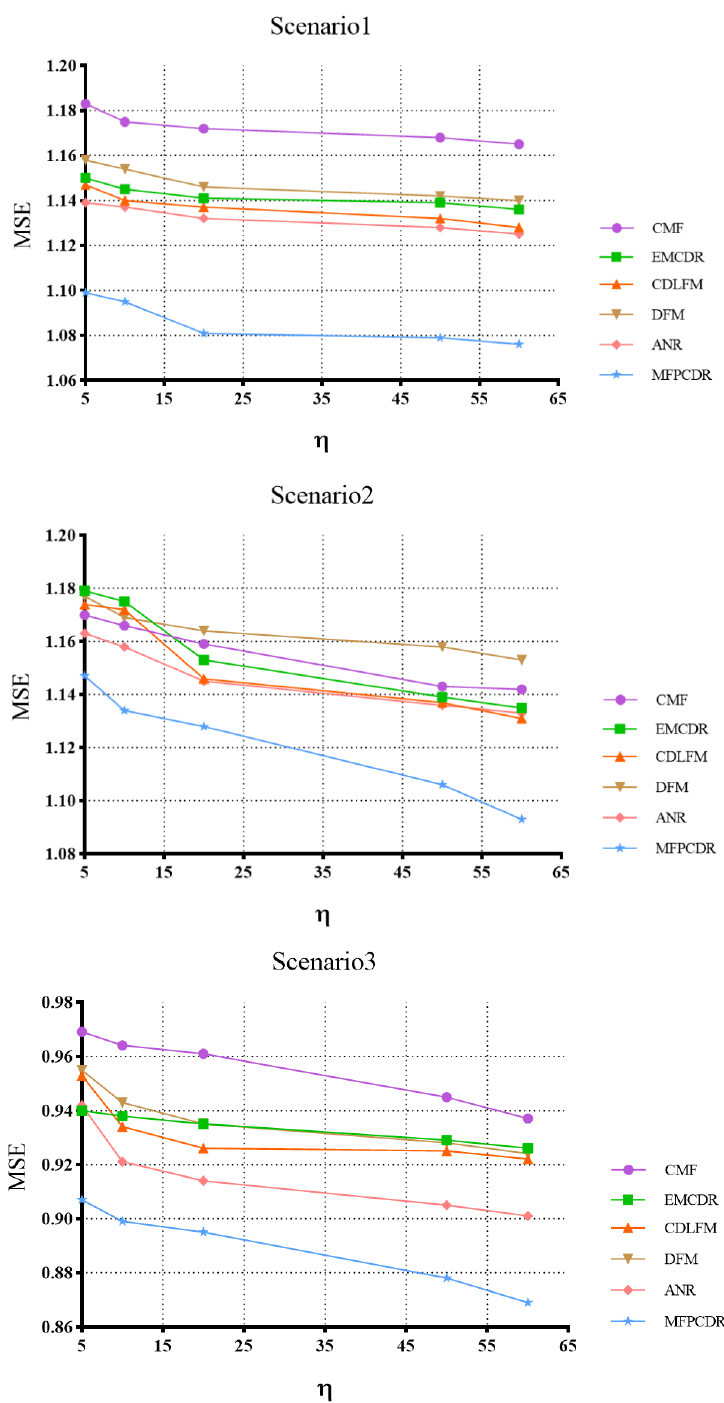
Figure 4. Impact of the proportion of overlapping users ( η represents the proportion of overlapping users). ping